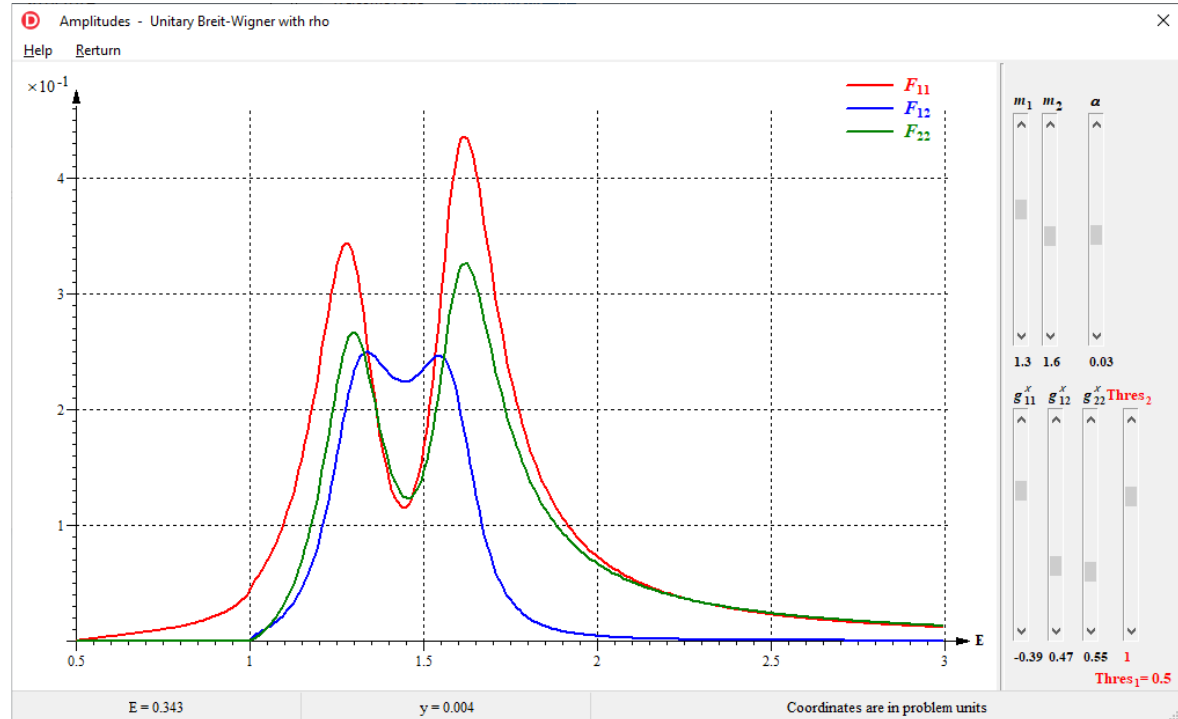
Figure A7. Unitary BW scattering amplitudes. BW parameters in Figure A7 are: ggg ====−==